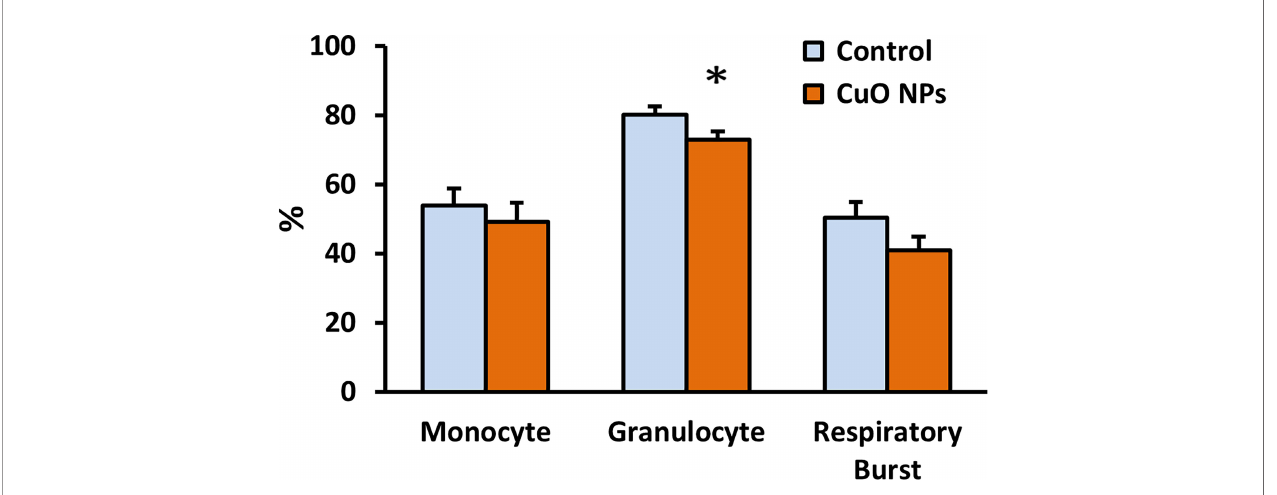
FIGURE 5 | Phagocytic activity and respiratory burst of leukocytes. Phagocytic activity of monocytes and granulocytes was evaluated using ingestion of fl uorescein- labelled Staphylococcus aureus , and the respiratory burst was monitored using hydroethidine by fl ow cytometry. Control – control group, CuO NPs – group exposed to CuO NPs. Blood was derived from mice exposed to CuO NPs for 6 weeks (n = 7) and controls (n = 8). Results are expressed as the percentage of phagocytic activity and respiratory burst. Bars indicate mean group activity of blood cells (mean + SEM). Signi fi cance: *p <